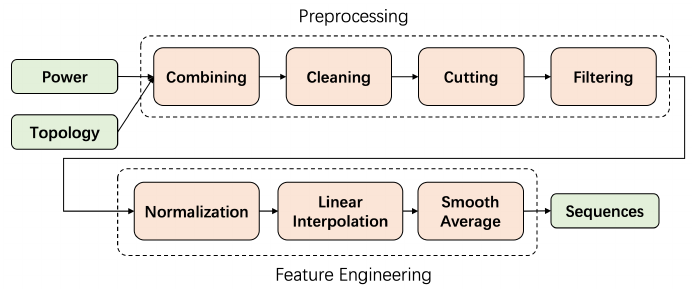
Figure 4. Preprocess and feature